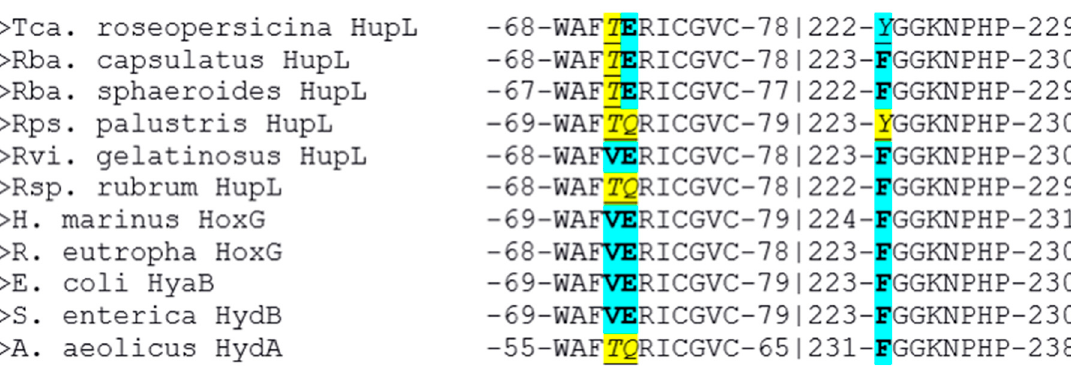
Figure 2. Microenvironment of the FeS clusters of the studied hydrogenases shown in multiple sequence alignment of large subunits. The amino acids found mainly in oxygen-tolerant hydrogenases are colored cyan and shown in bold type; those found in oxygen-sensitive hydrogenases are colored yellow and shown in underscored italic. NB: despite the presence of TQ-motif, hydrogenase from Aquifex aeolicus is also